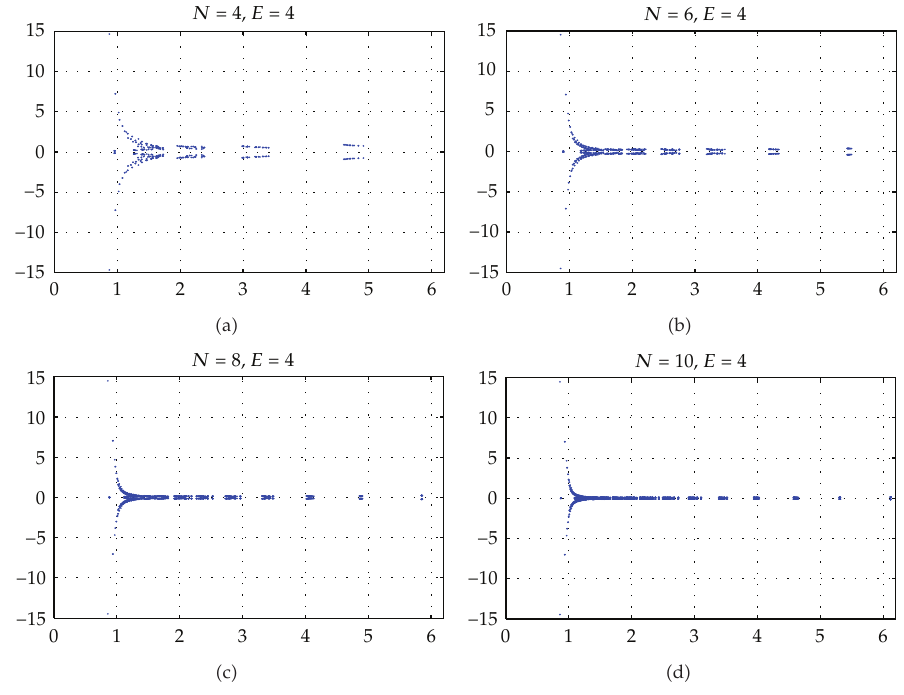
(cid:2) A (cid:2) B − 1 N (cid:2) 4 , 6 , 8 , 10 and E (cid:2) 4 when δ (cid:2) 10 − 4 , b (cid:2) (cid:5) 1 , 1 (cid:6) T N 2 for h 2